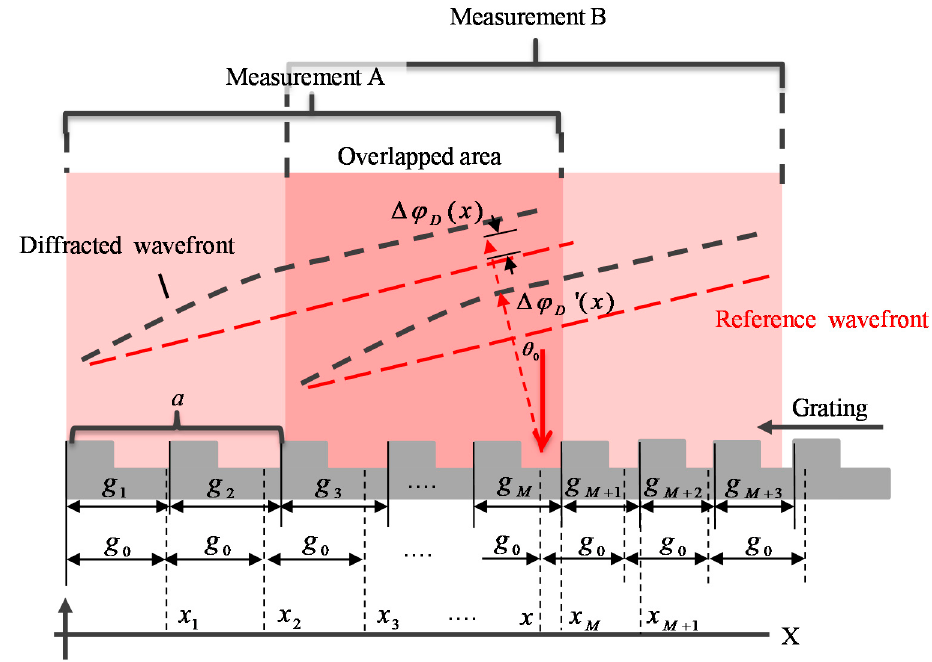
Figure 3. Schematic of the phase error generated by the X -directional pitch deviation in stitching measurement.